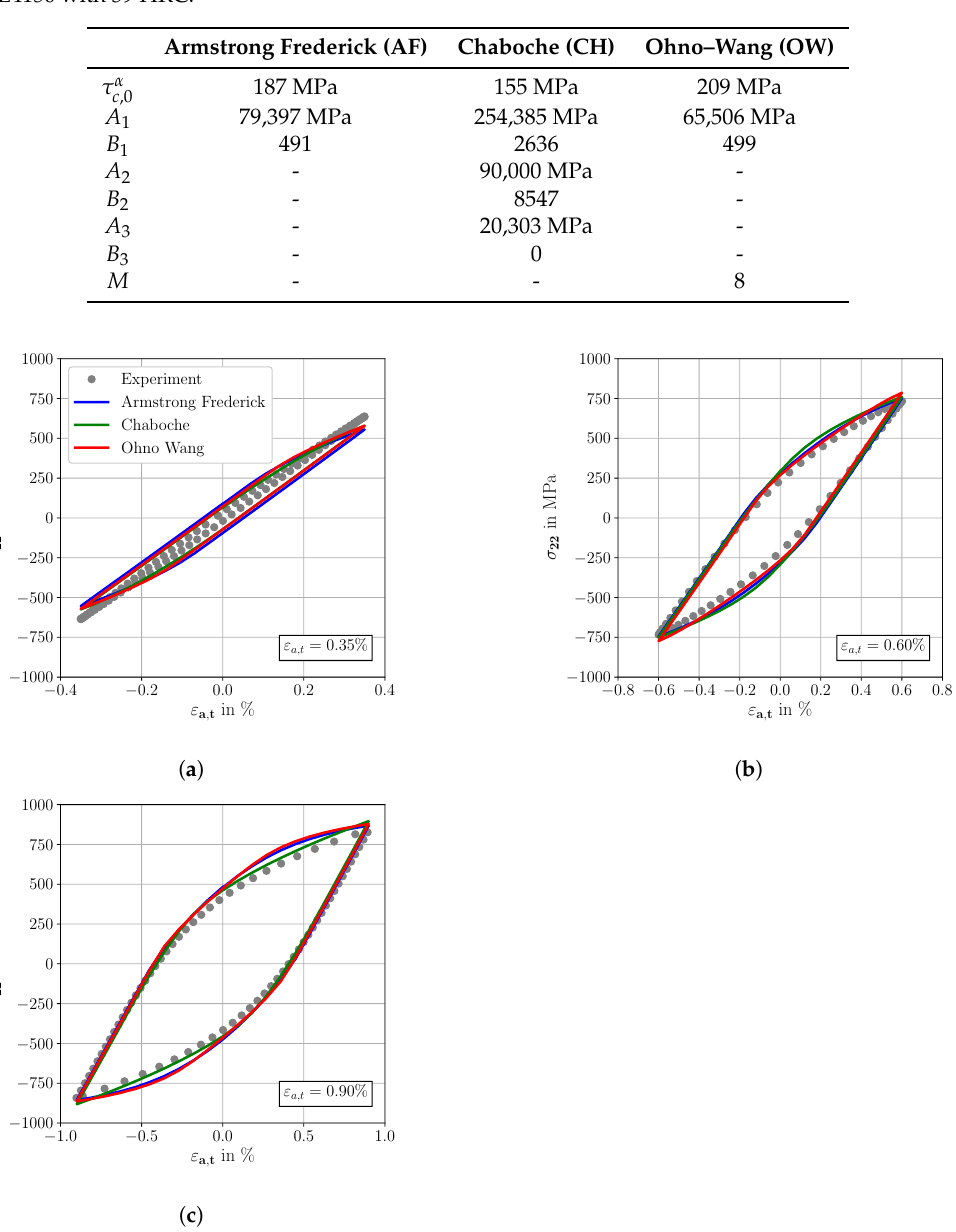
Table 4. Optimized parameter sets for different kinematic hardening models for quenched and tempered SAE4150 with 39 HRC.